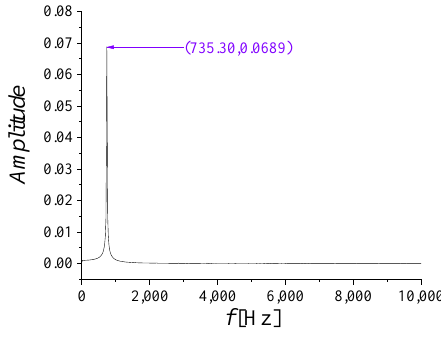
Figure 6. Characteristics of the lift curve in the frequency domain.